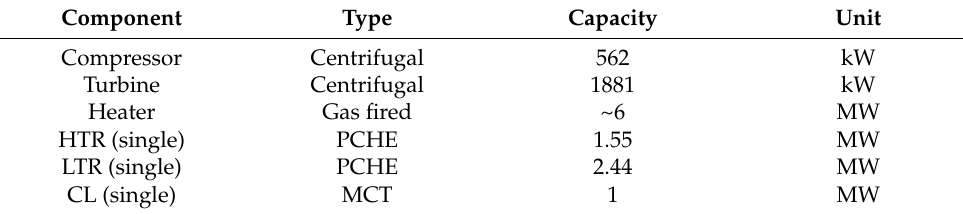
Table 3. Parameters of each